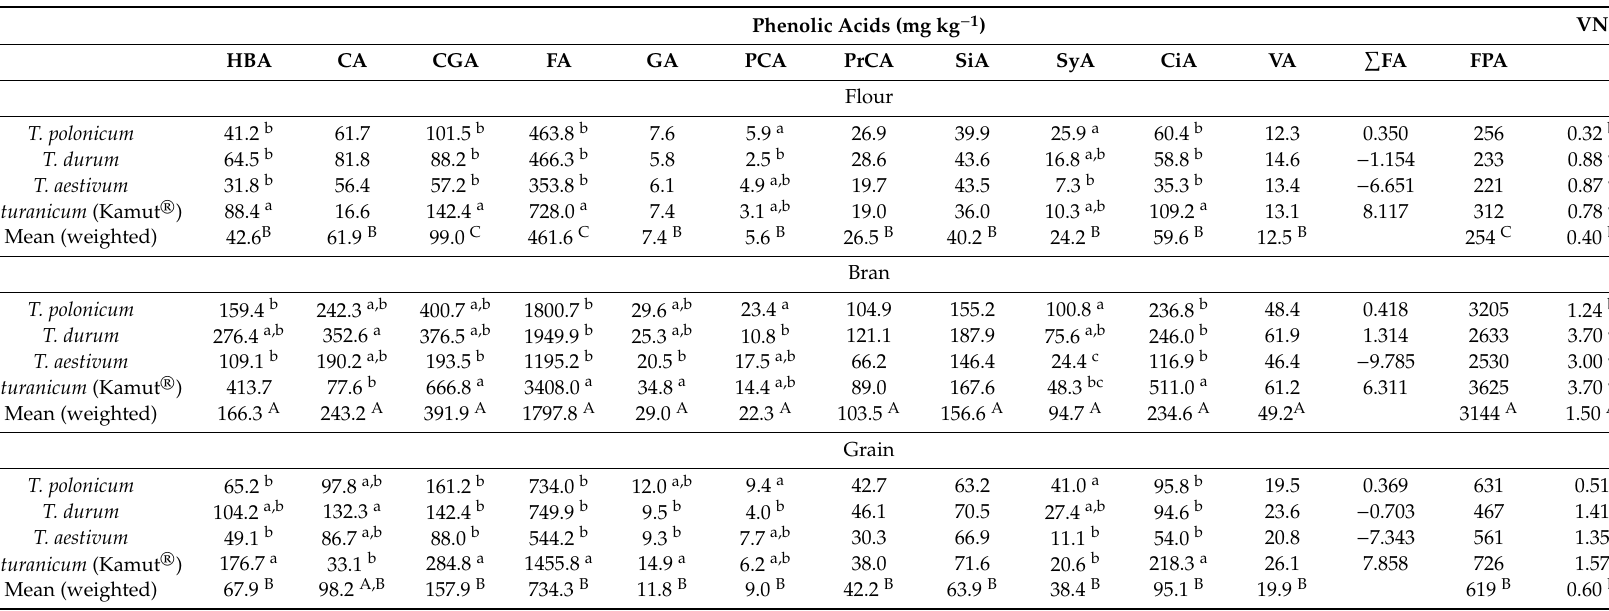
Table 3. Concentrations of bound phenolic acids, free phenolic acids, and vanillin in the flour, bran, and grain of 66 T. polonicum lines versus four T. durum cultivars, four T. aestivum cultivars, and Kamut ®